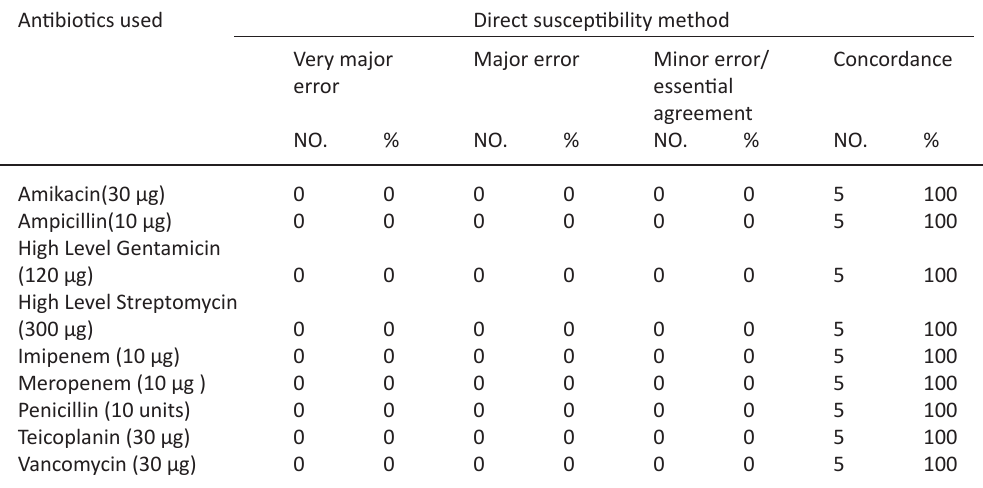
Table 7 . Direct antibiotic susceptibility correletion for Enterococcus faecium and Enterococcus faecalis (n=5) Antibiotics